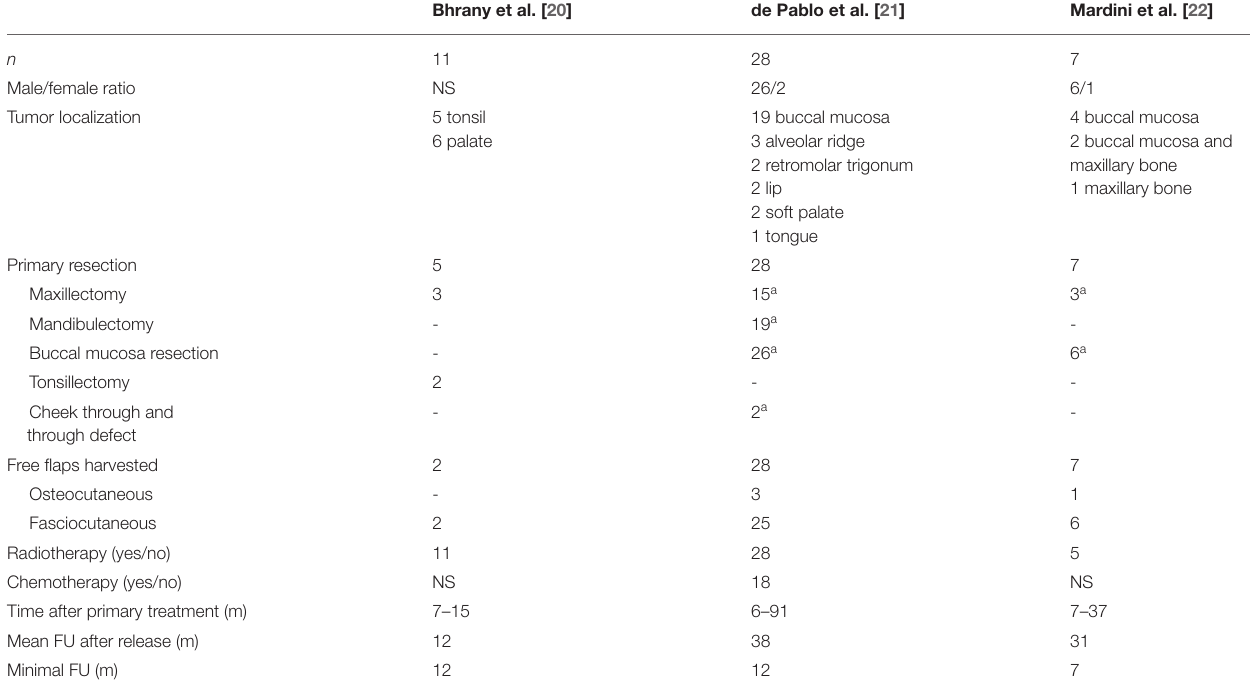
TABLE 2 | Demographics of the included cases.